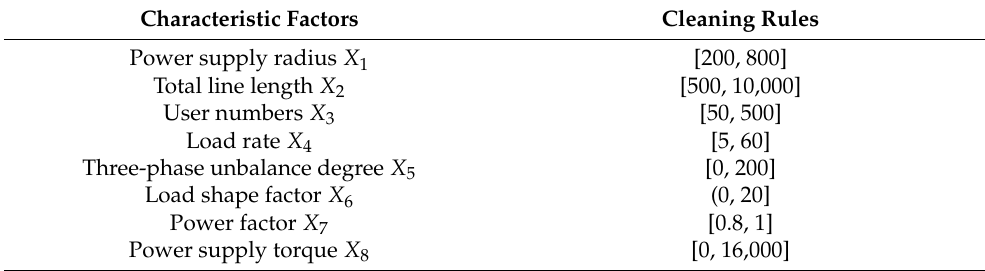
Table 3. Cleaning rules of characteristic